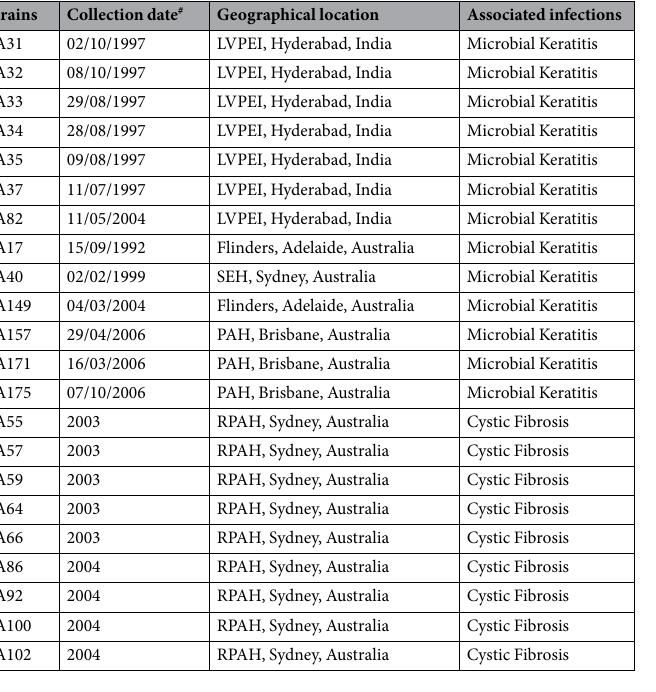
Table 5. List of strains used in this study. LVPEI = LV Prasad Eye Institute; Flinders = Flinders University, SEH = Sydney Eye Hospital; PAH = Princes Alexandra Hospital; RPAH = Royal Prince Alfred Hospital CF Clinic, Sydney, Australia. # All cystic fibrosis isolates were obtained from Royal Prince Alfred Hospital CF Clinic, Sydney, Australia, between 2003 and 2004. Information on exact date of collection is missing in our